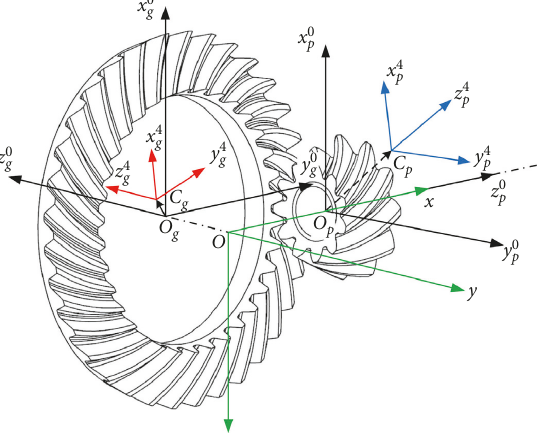
Figure 2: Coordinate systems of a spiral bevel gear pair.